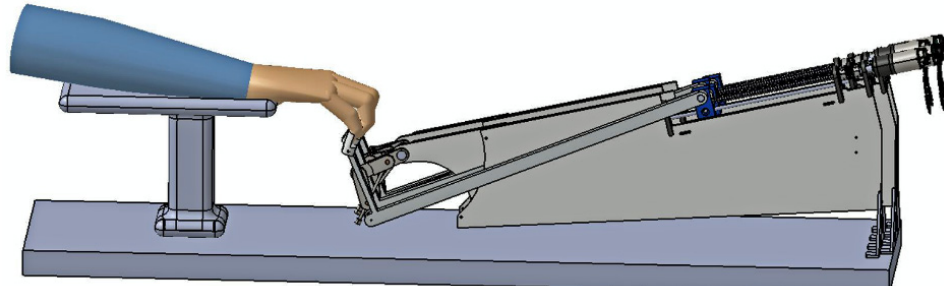
Figure 6. The four-bar slider-crank type mechanism.